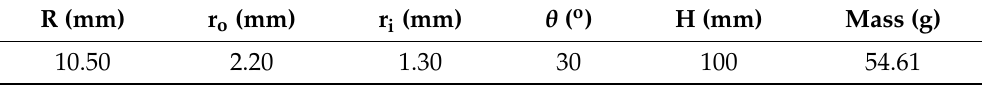
Figure 3. Parameters defining the topology of a chiral structure. Table 1. Design parameters and physical properties of the chiral lattice